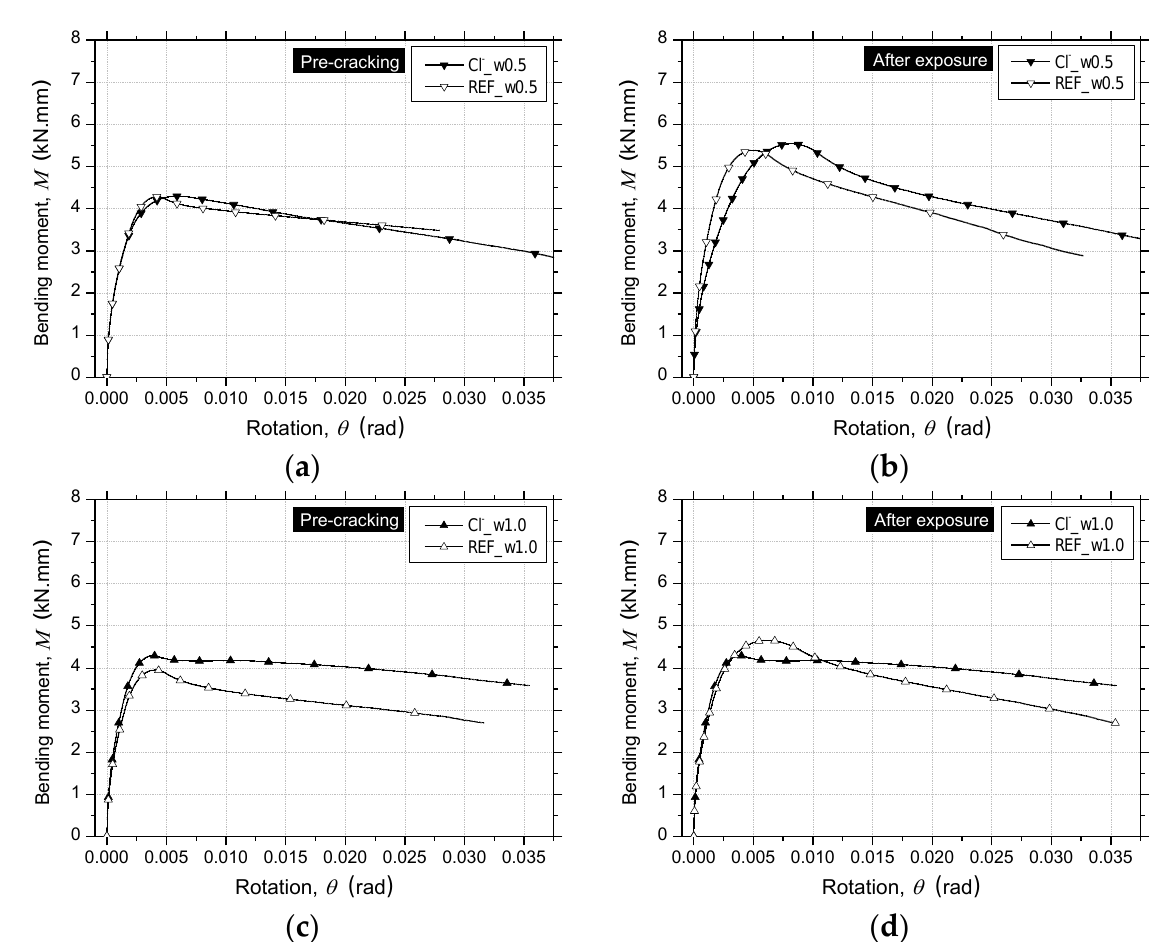
Figure 16. Moment–rotation ( M − θ ) relationships obtained by inverse analysis from RPT-3ps of RSFRC panels with the target ω cr of 0.5 mm ( a ) during the pre-cracking stage and ( b ) after environmental exposure; and the target ω cr of 1.0 mm ( c ) during the pre-cracking stage and ( d ) after environmental exposure.